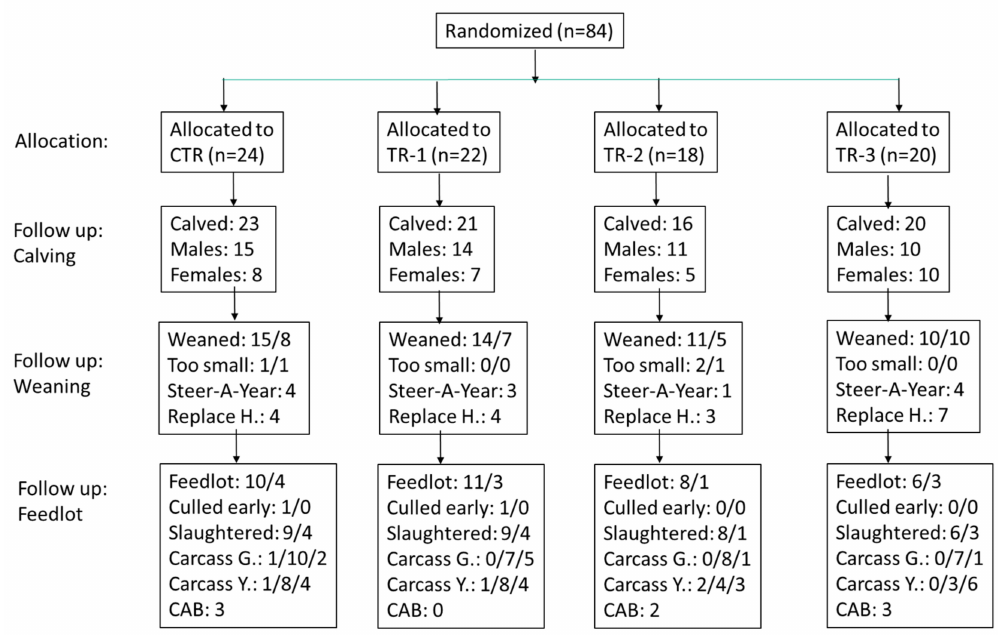
Figure 1. Flow chart of the maternal Se-supplementation study. For follow-up weaning and follow-up feedlot data, the number before the slash represents the number of males and the number after the slash represents the number of females. “Too small” refers to weaned calves that could not be sold to the feedlot because of their small size. “Steer-A-Year” refers to a beef production course that elected to keep some of the larger steers, and “Replace H.” refers to heifers that were kept by the Soap Creek Ranch for replacements. “Culled early” refers to calves in the feedlot that did not reach slaughter weight. “Carcass G.” refers to carcass grade, with the number before the slash reporting the number of calves graded “prime”; the second number is the number of calves graded “choice”; and the third number is the number of calves graded “select”. “Carcass Y.” refers to carcass yield, with the number before the slash reporting the number of calves with yield = 1; the second number is the number of calves with yield = 2; and the third number is the number of calves with yield = 3. “CAB” refers to “Certified Angus Beef ® ” with the number of calves attaining this quality certification so